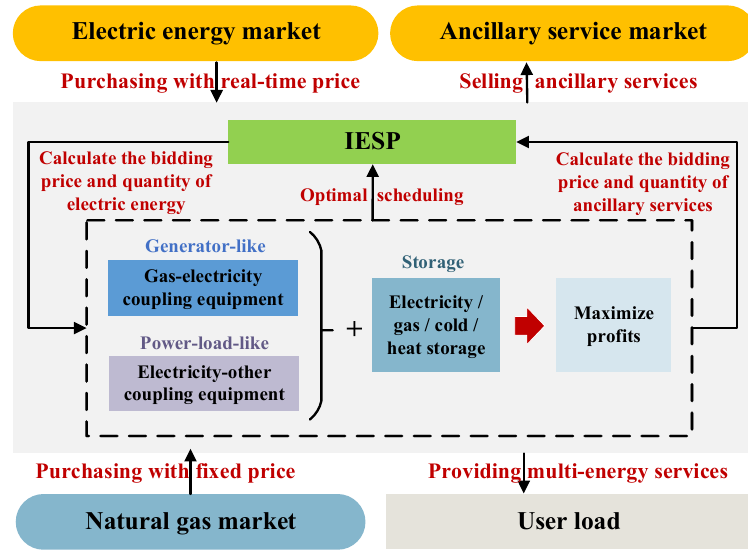
Figure 1. Operation of the